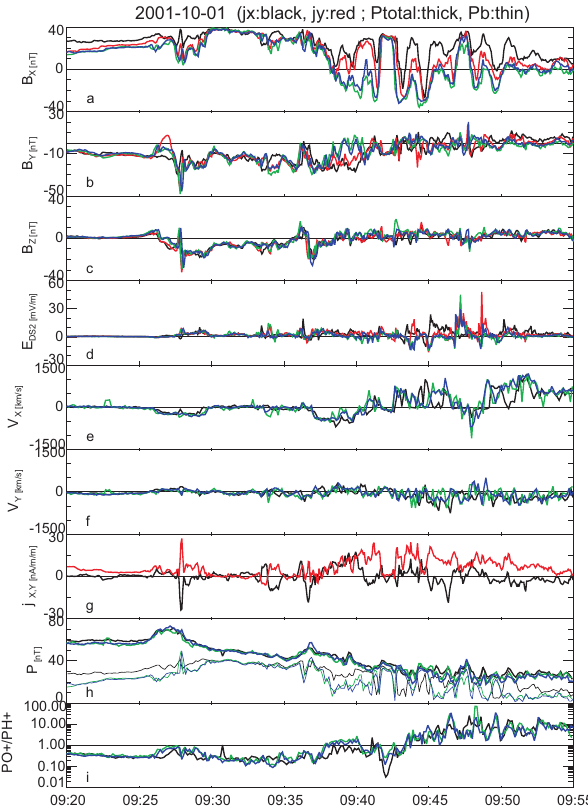
Fig. 9. Same format as Fig. 8 except for the bottom two panels, which are: (h) total and magnetic pressure, and (i) ratio between oxygen and hydrogen pressure. In the pressure plot the total and the magnetic pressures are plotted with thick and thin lines, respec-